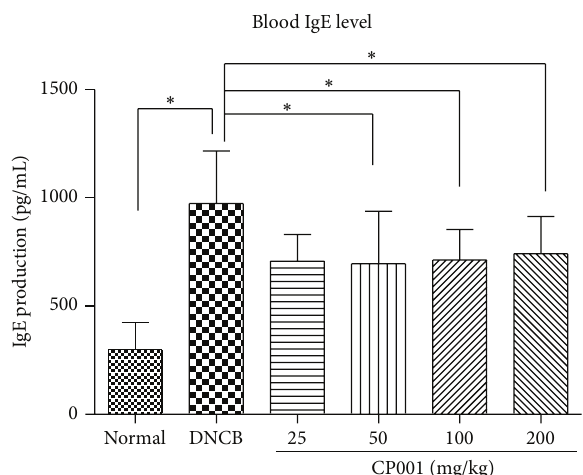
Figure 5: Measurement of plasma IgE level. Total IgE level was determined by ELISA. The columns and the error bars represent mean ± SEMs ( 𝑛 = 4 mice/group). ∗ 𝑃 < 0.05